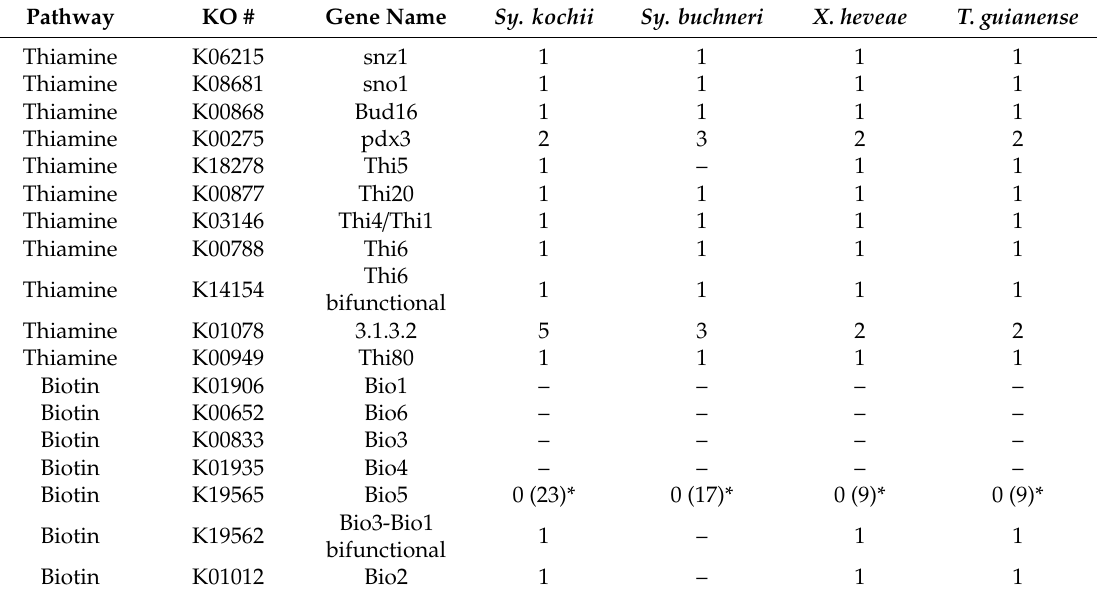
Table 5. B vitamin biosynthesis pathway (thiamine and biotin) comparison among Xylonomycete genomes. Pathway